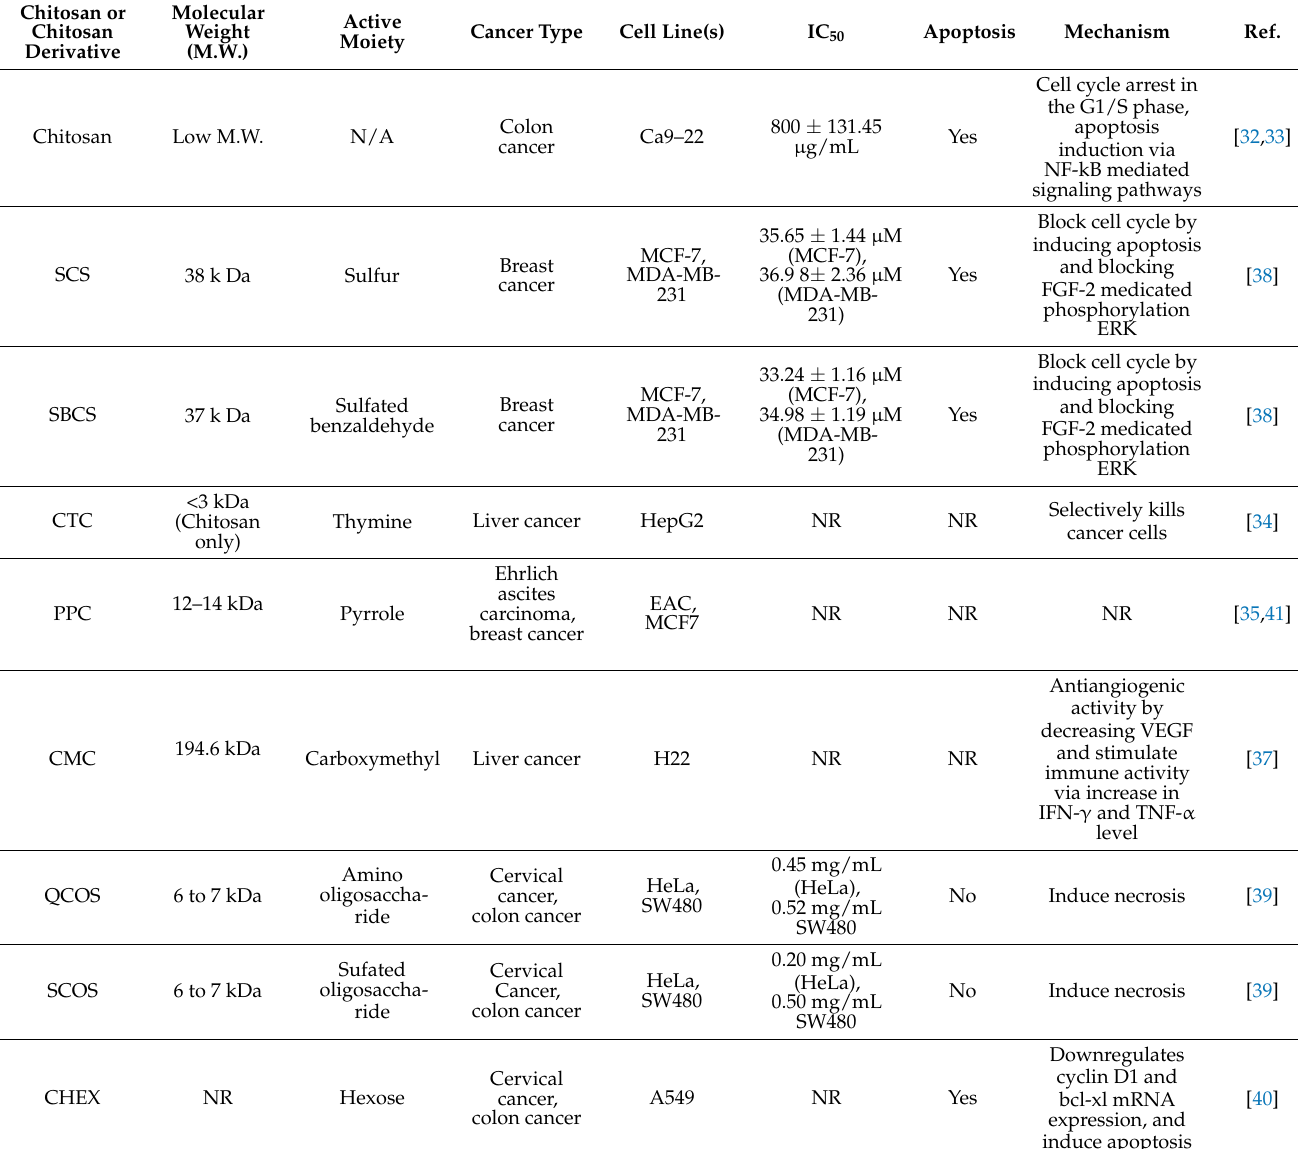
Table 1. Anticancer activity of chitosan and chitosan